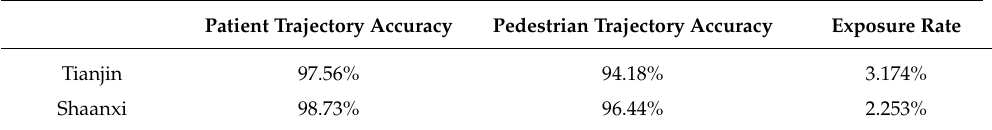
Table 4. Summary of relevant track results of Tianjin and Shaanxi Province.